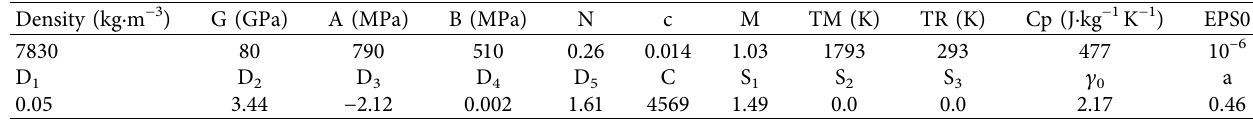
Table 2: The cartridge and its state equation parameters.